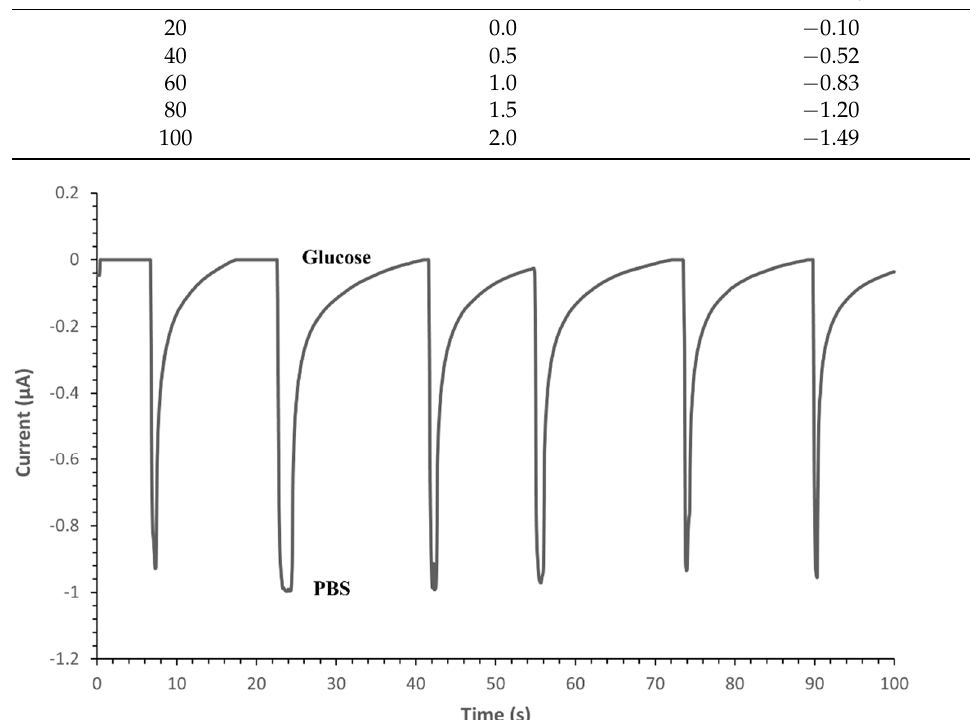
Figure 6. Amperometric current response at –0.1 V (vs. Ag/AgCl R.E.) with alternate injecting of glucose (0.5 mM~2.0 mM glucose in increments of 0.5 mM) and PBS.